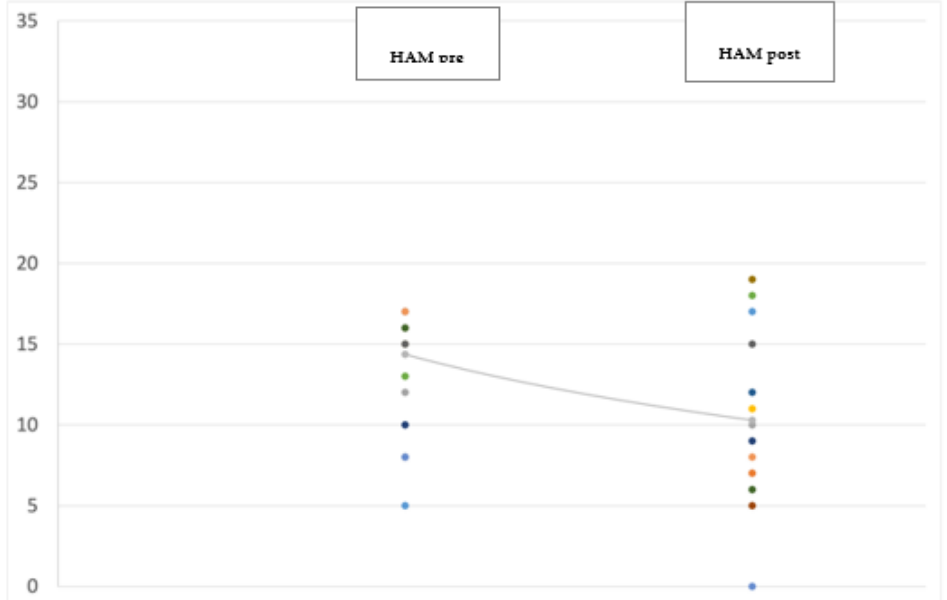
Figure 2. Jittered scattered plot showing the preoperative ( left ) and postoperative ( right ) Hamilton Anxiety Rating Scale values of the 14 patients in the study. The difference between the preoperative ONmed and postoperative ONstim showed a p -value = 0.041. The line shows the negative (improving) trend of the values.